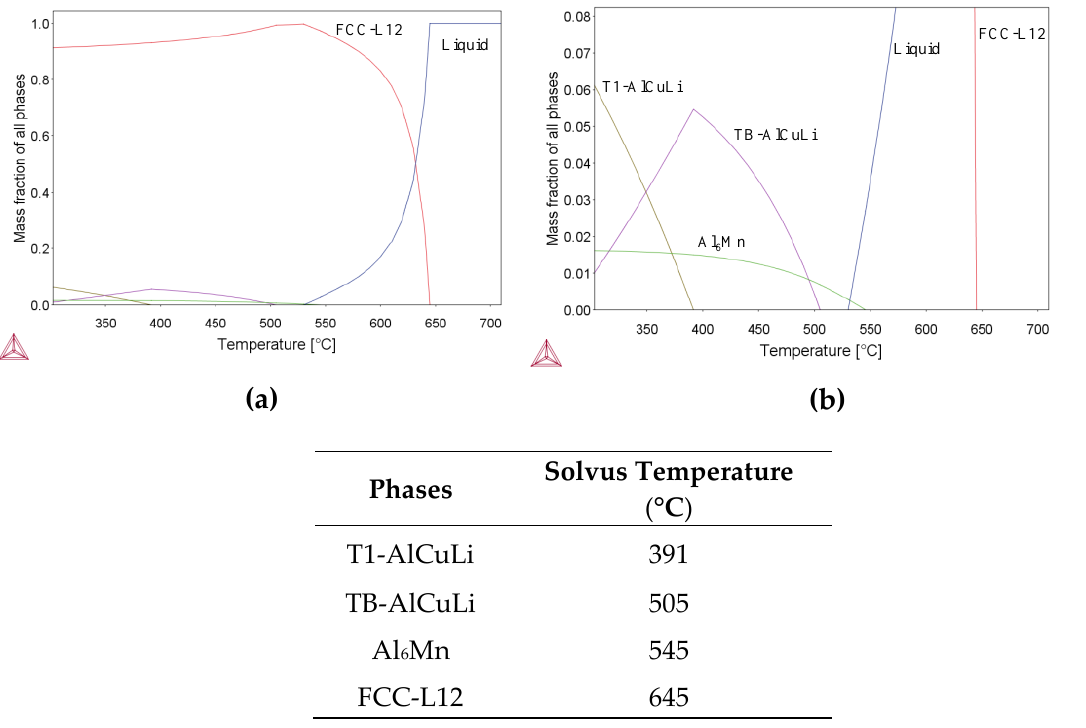
Figure 7. Mass fraction of all phases as a function of temperature ( a ) Major phases ( b ) Minor phases and values of solvus temperatures from simulations.